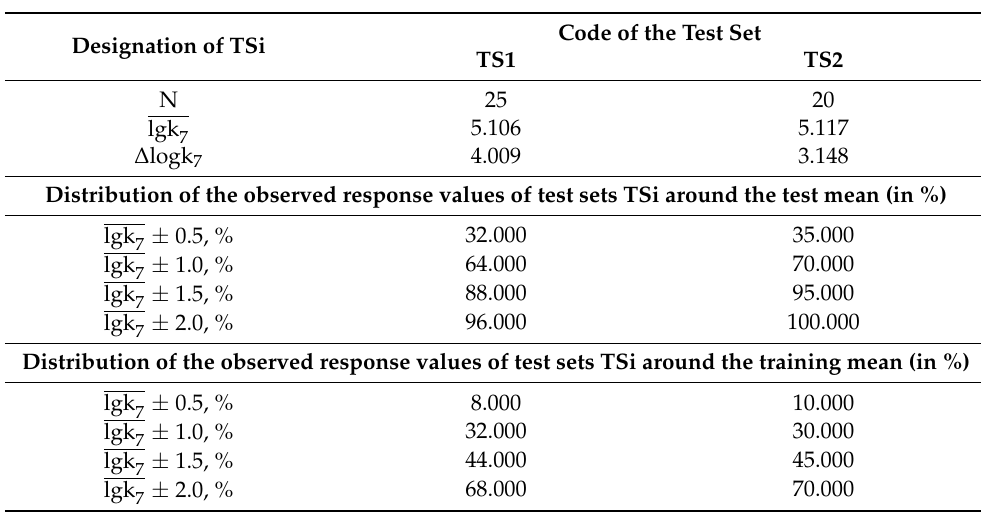
Table 7. Statistical characteristics of test sets TS1,